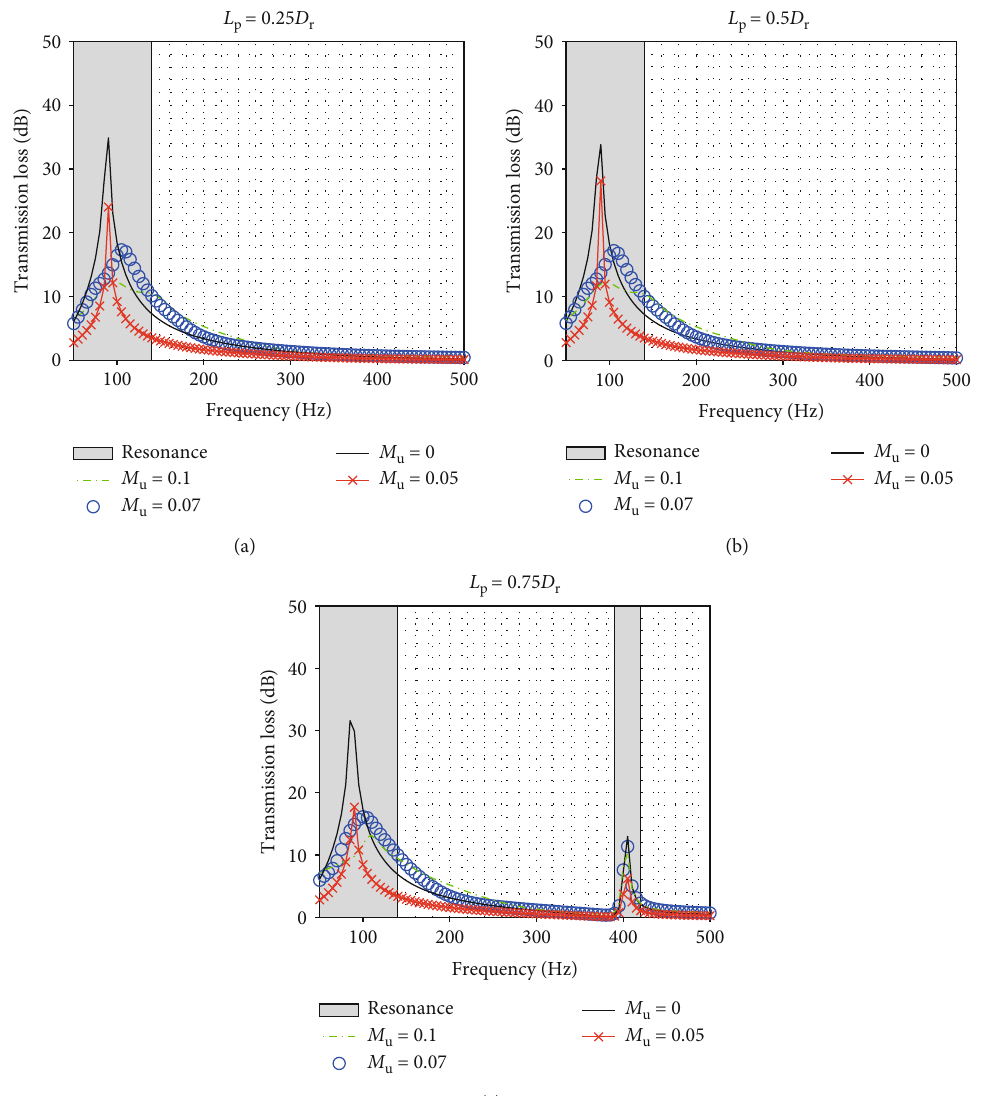
Figure 8: Transmission loss varied with the forcing frequency, as M / D is changed from 0.25 to 0.5 and 0.75. (a) L and L p r 411Hz corresponding to L